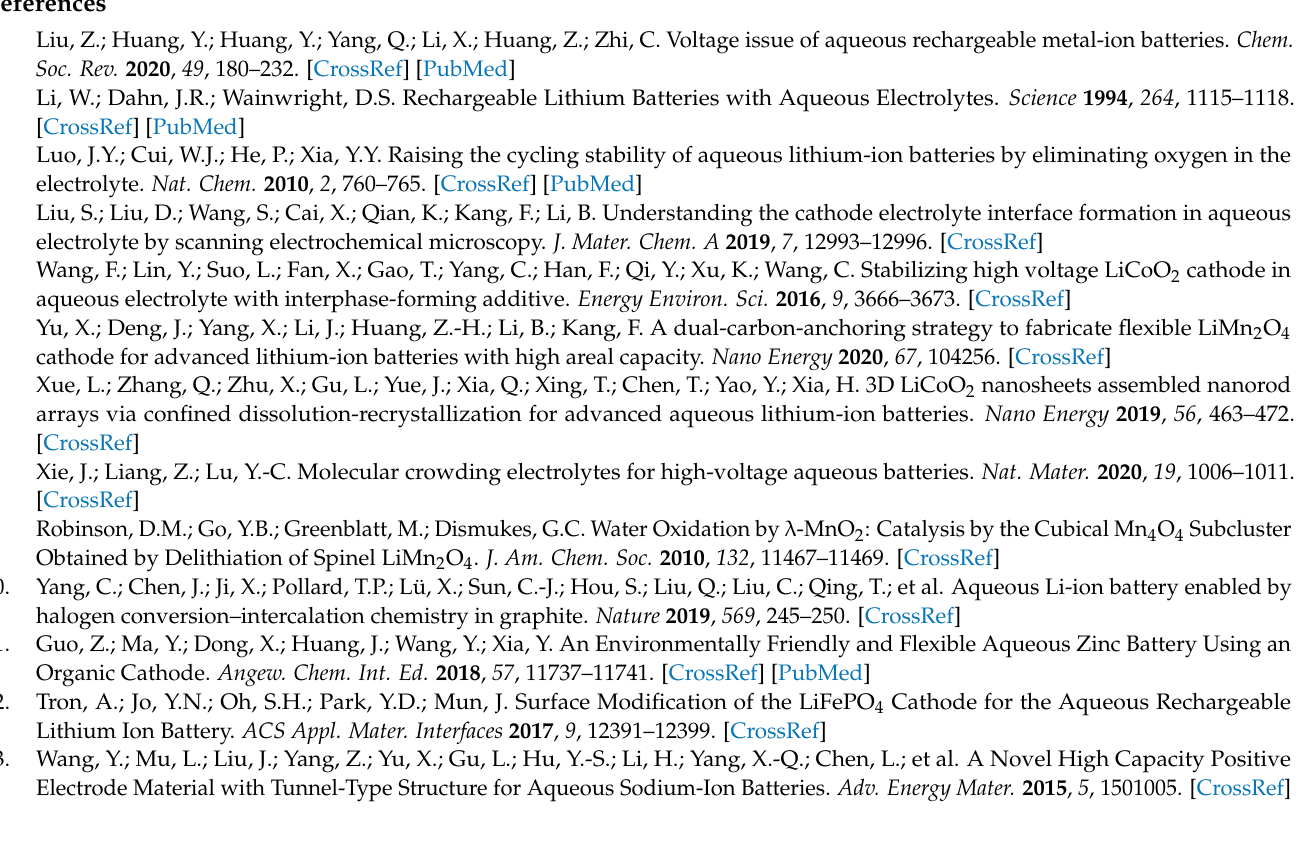
Figure S9: SEM images of ( a , b ) NTP and ( c , d ) LMO. Figure S10: ( a ) TEM image, ( b ) high-resolution TEM image corresponding to the squared area in ( a ), and ( c ) lattice distance pattern obtained through the analysis with Gatan Software for NTP. Figure S11: Electrochemical performance of NTP in a three-electrode system: ( a ) CV at 0.3 mV s − 1 in a potential range of − (1.1–0.2) V, ( b ) GCD curves, ( c ) cycling performance at 1 A g − 1 , and ( d ) Nyquist plots before and after cycling at 1 A g − 1 . Figure S12: Electrochemical performance of LMO in a three-electrode system: ( a ) CV at 0.3 mV s − 1 in a potential range of 0.4–1.2 V, ( b ) GCD curves, ( c ) cycling performance at 1 A g − 1 , and ( d ) Nyquist plots before and after cycling at 1 A g − 1 . Figure S13: Nyquist plots of NTP (cid:107) LMO operating with LN-SDS-90 before and after cycling at 5 C for 2000 cycles, at room temperature. Figure S14: GCD curves of NTP (cid:107) LMO operating with LN-SDS-90 at varying C rates and at room temperature. Table S1: Comparison of the specific energy between NTP (cid:107) LMO and other ARMBs. References [76–81] are cited in the Supplementary